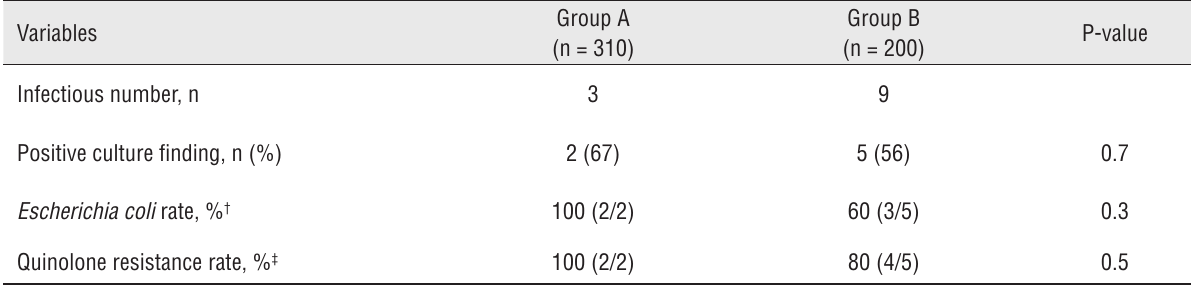
Table 3 - Culture data of the patients with infection-related hospitalizations in the two groups.